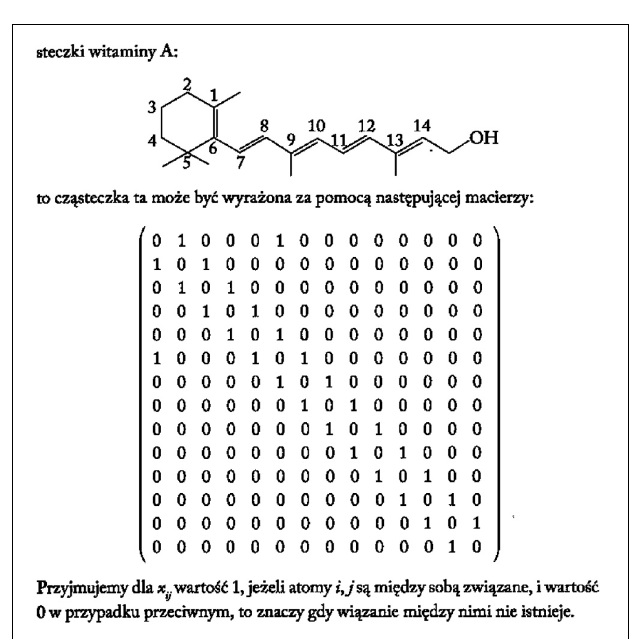
regulator (center), or by an independent receptor associated to the histidine kinase(right).Thisschemerepresentsthebasictaxonomyofbacterialsignaling; the three different options imply very different information processing capabilities and metabolic costs (Modified from Marijuán et al., 2010).